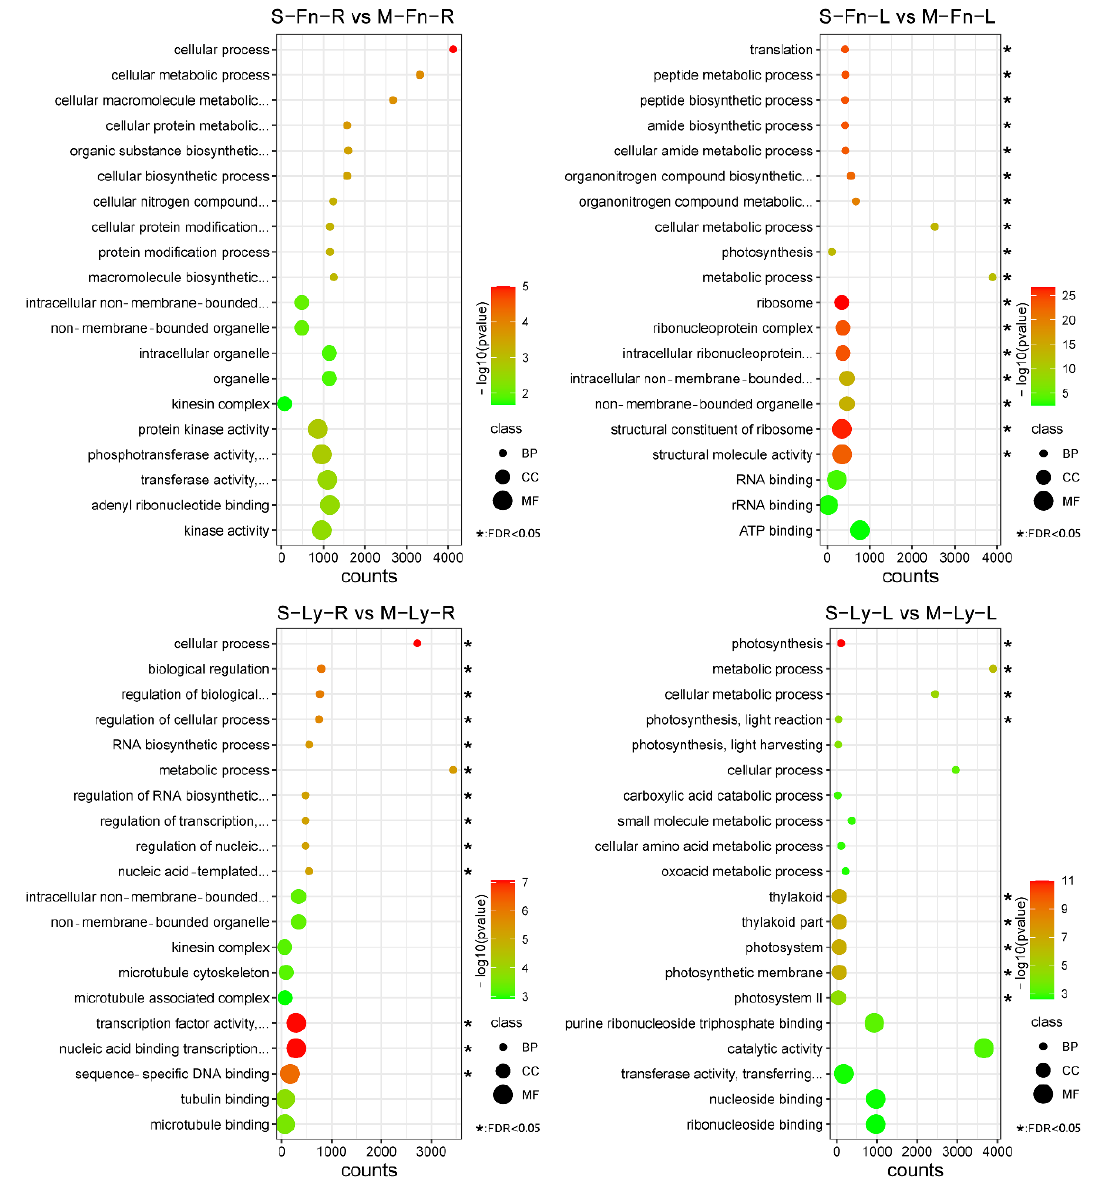
Figure 5. GO classification and enrichment analysis of differentially expressed genes (DEGs) between root and leaf in Fanni and Longya10 under 100 mM NaCl solution. M–Fn–R and M–Ly–R represent the root samples derived from Fanni and Longya10 plants, respectively. S–Fn–R and S–Ly–R represent the saline-stress-treated root samples derived from Fanni and Longya10 plants, respectively. M–Fn–L and M–Ly–L represent the leaf samples derived from Fanni and Longya10 plants, respectively. S–Fn–L and S–Ly–L represent the saline-stress-treated leaf samples derived from Fanni and Longya10 plants, respectively.